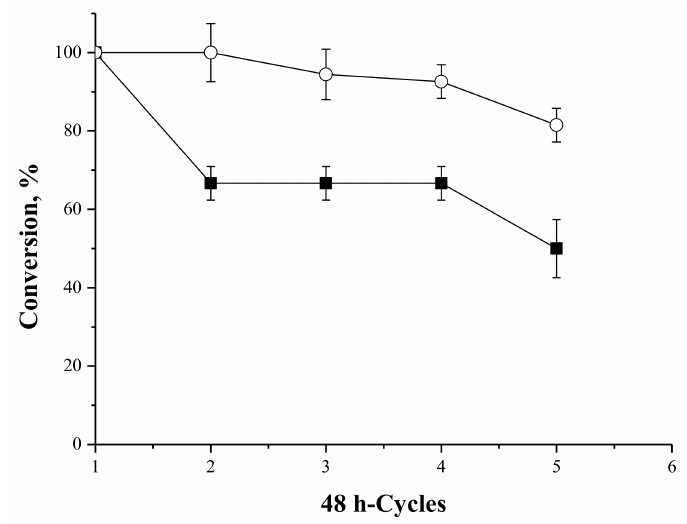
Figure 11. Relative conversion as a function of the number of recycles for syntheses of fructose oleate at 45 ◦ C, cycles of 48 h reaction, 250 rpm stirring, 25 mM of initial concentrations of fructose and oleic acid using PFL-octyl-silica ( (cid:4) ) and oleic acid initial concentration of 25 mM, fructose initial concentration of 50 mM using IMMCALB-T2-350 ( ). All assays were carried out in tert -butyl alcohol as solvent, 0.5 (cid:35)